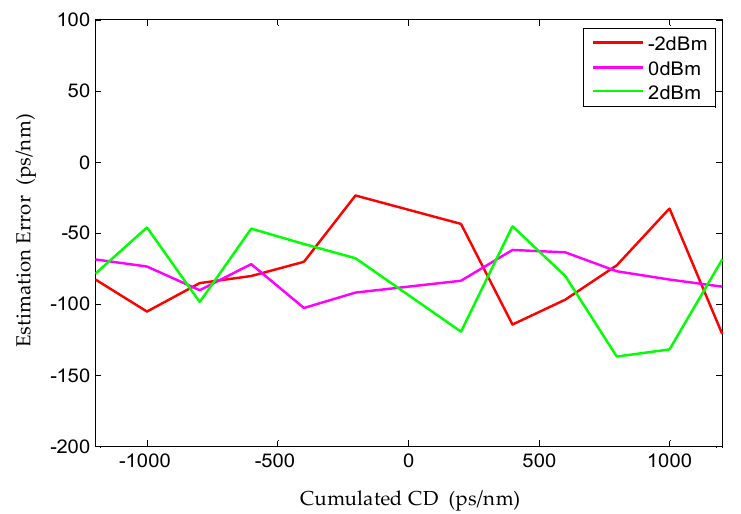
Figure 18. CD estimation error results of the OOK signal under different input